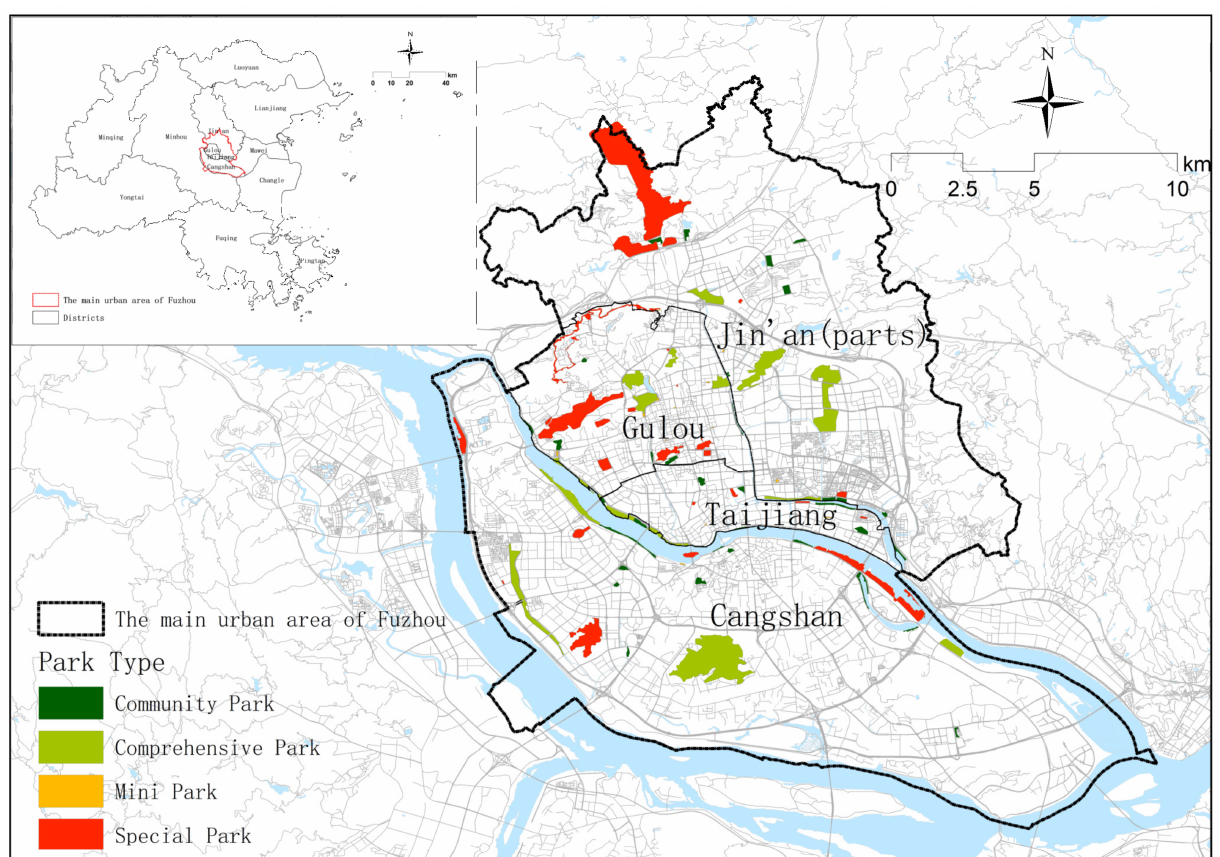
Figure 1. Study area: The main urban area of